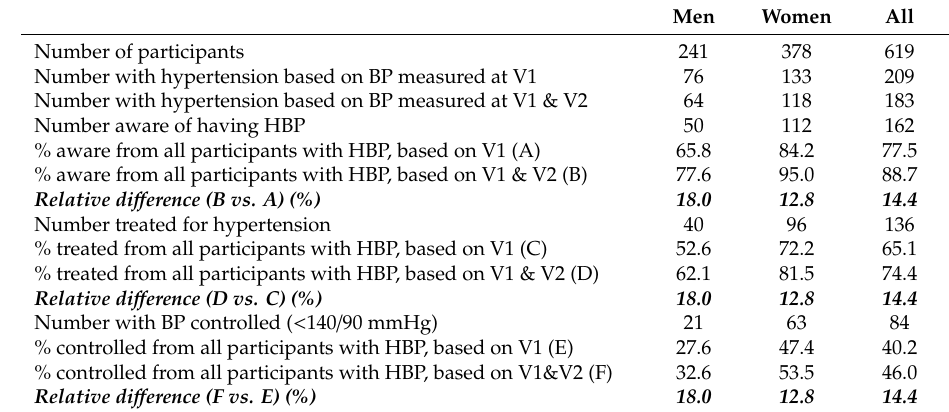
Table 5. Proportions of participants in the community-based screening programme who were aware, treated and controlled for hypertension based on the total number of persons with hypertension was based on blood pressure measured on two vs. one